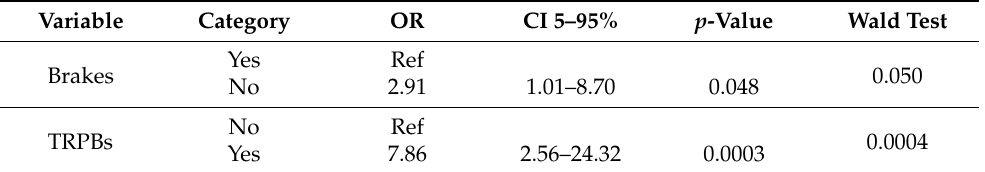
Table 9. Results of the univariable logistic regression with the variables associated with transport- related horse injuries reported in the replies ( n = 148) to a survey on horse road transport in Italy. Results are expressed as the odds ratio (OR), confidence interval (95% CI), p -value for each predictive variable and total p value of the Wald test.